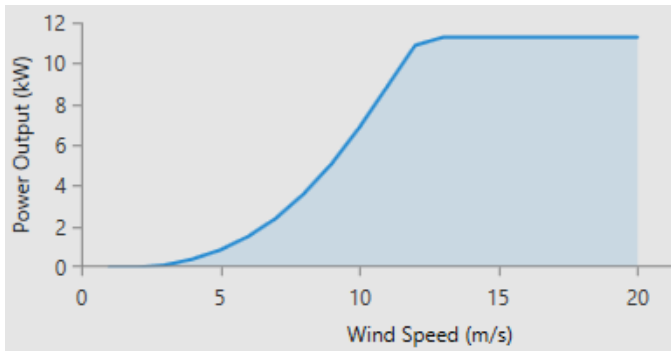
Figure 9. Power curve of the selected wind turbine.